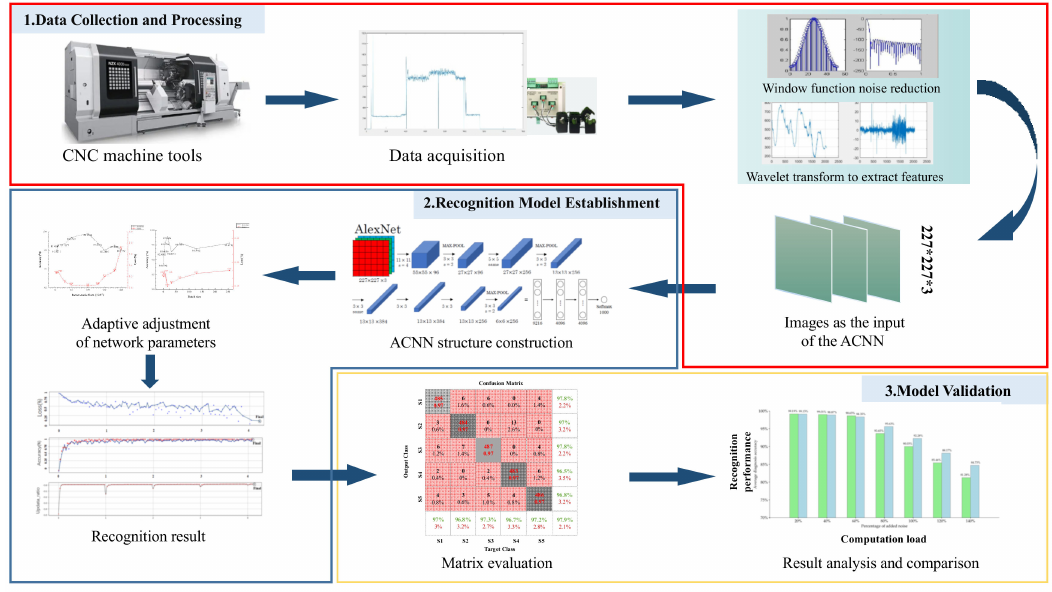
Figure 2. The general framework of the proposed